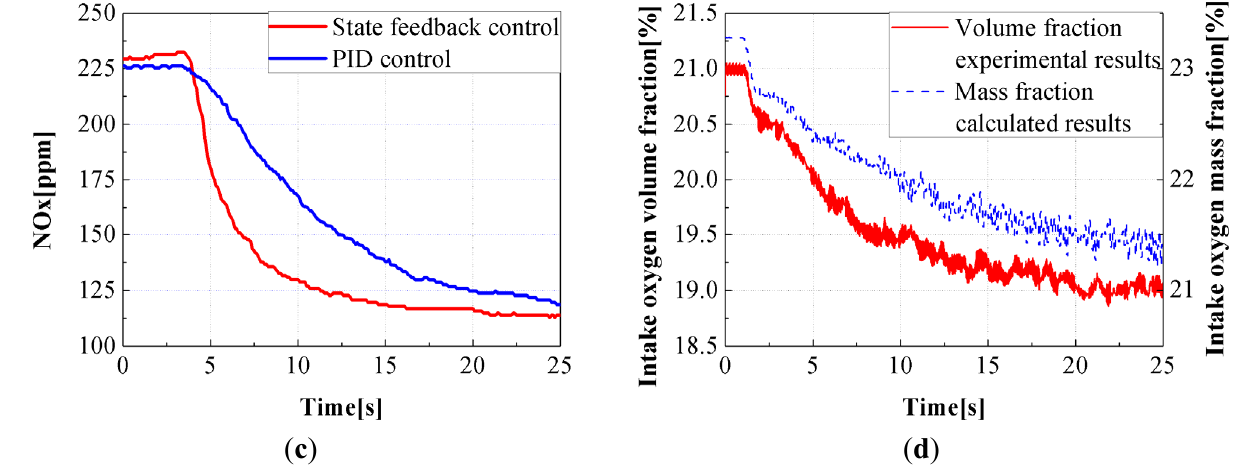
Figure 12. Comparison of the two kinds of control algorithm under steady state conditions: ( a ) Intake oxygen mass fraction calculated results; ( b ) EGR valve opening; ( c ) NO x ; ( d )